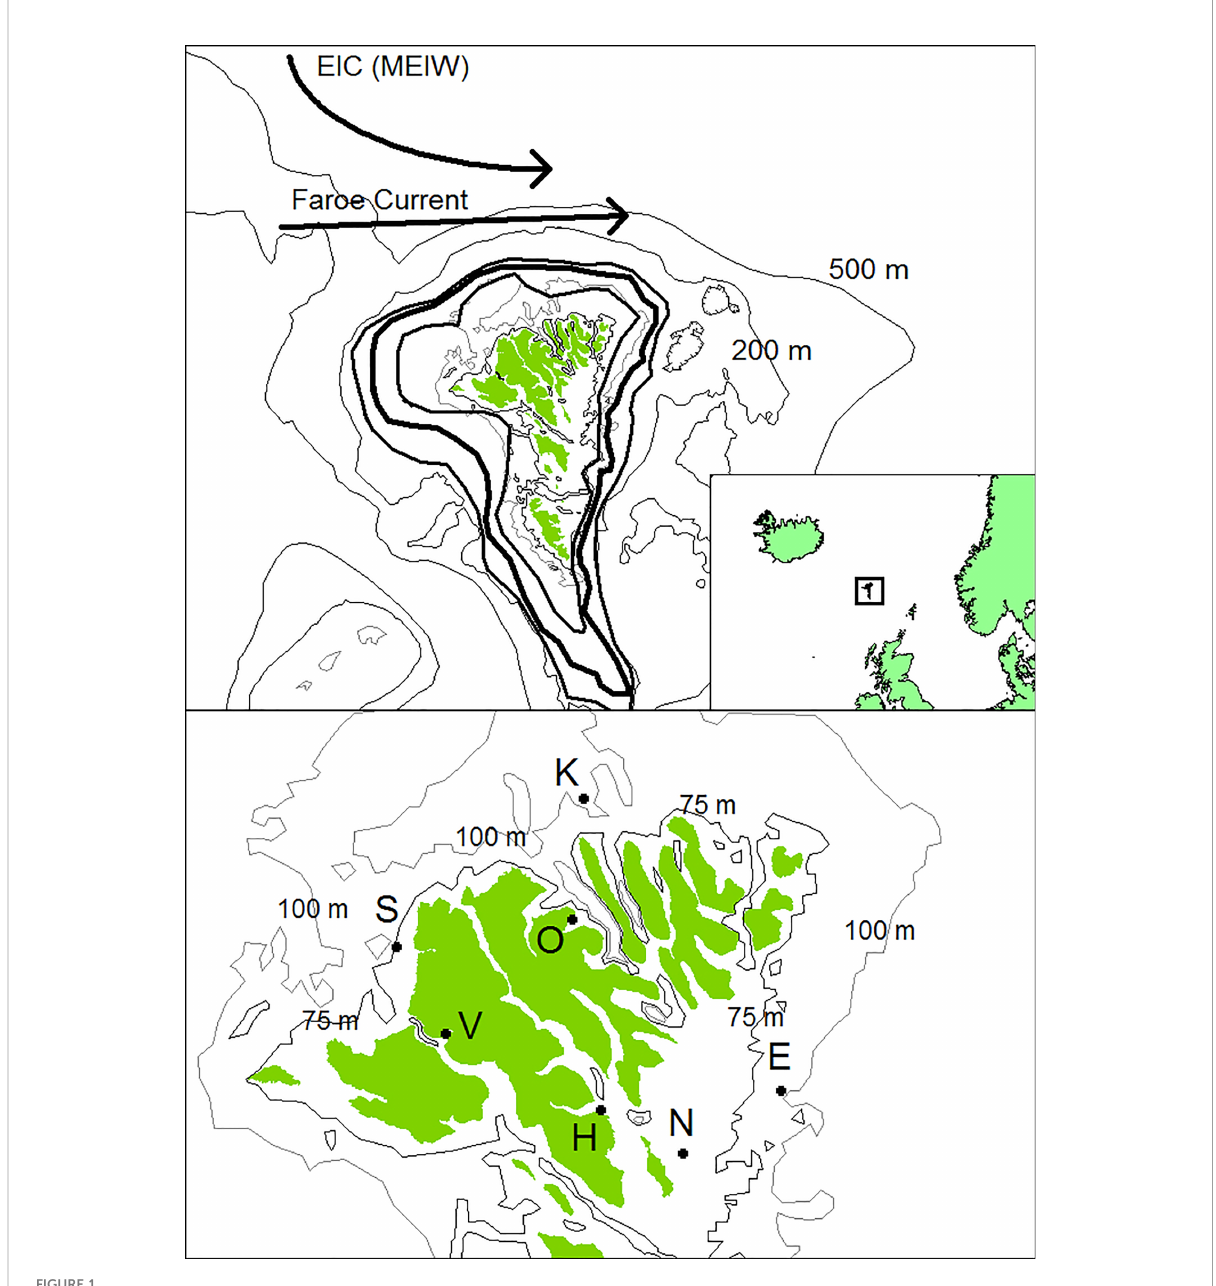
FIGURE 1 Locations of the sites where the A. islandica specimens were collected. The position of the tidal front (+/- 1 SD) is indicated by thick lines (based on Larsen et al., 2009). The location of the Faroe Current and the East Icelandic Current (EIC) or Modi fi ed East Icelandic Water (MEIW) is also shown. Thin lines show 75, 100, 200 and 500 m depth